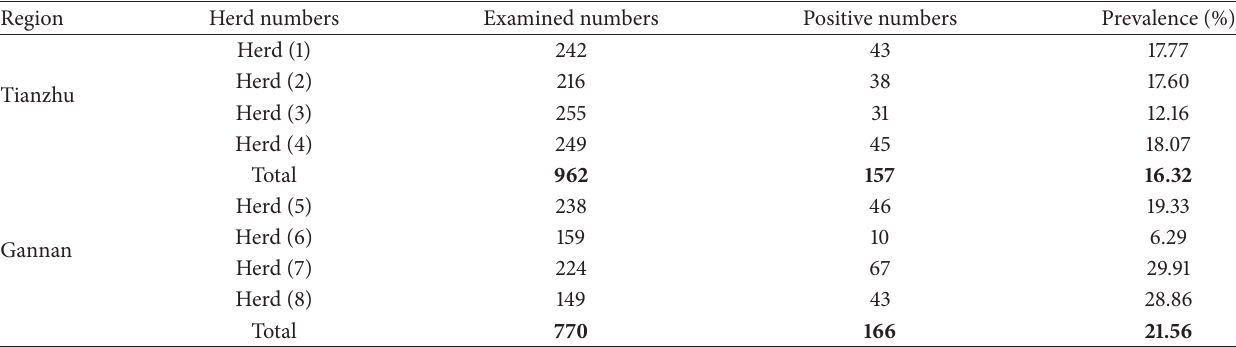
Table 2: Seroprevalence of Chlamydia abortus infection in Tibetan sheep in eight herds in two regions in Gansu, China. Region Herd numbers